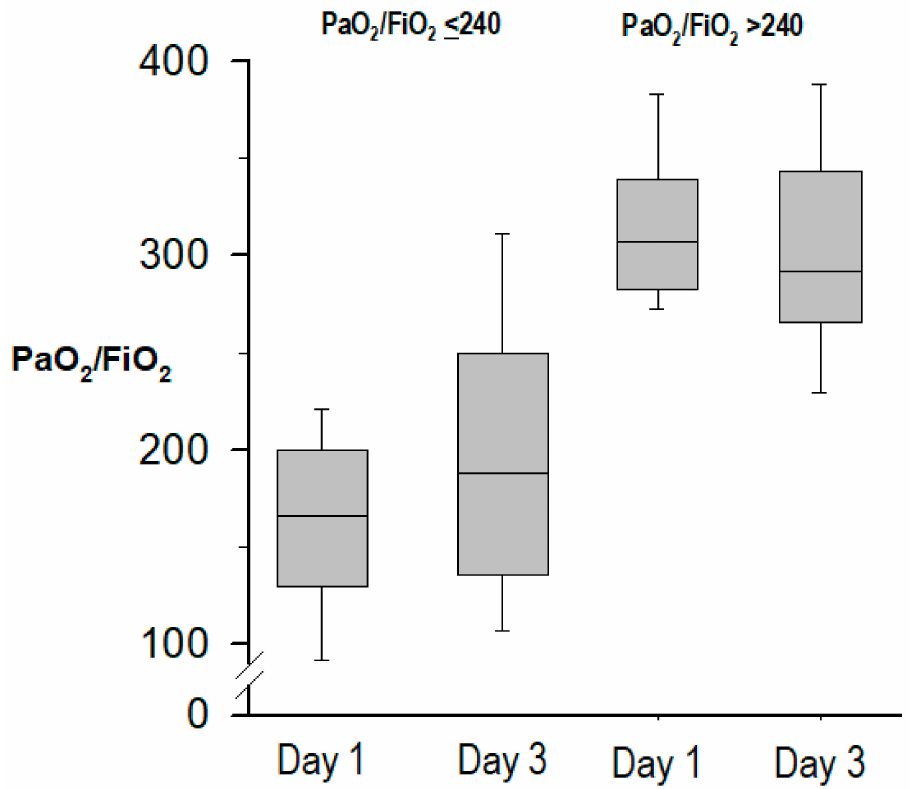
Figure 2. Evolution of PaO 2 / FiO 2 from pneumonia onset (day 1) to day